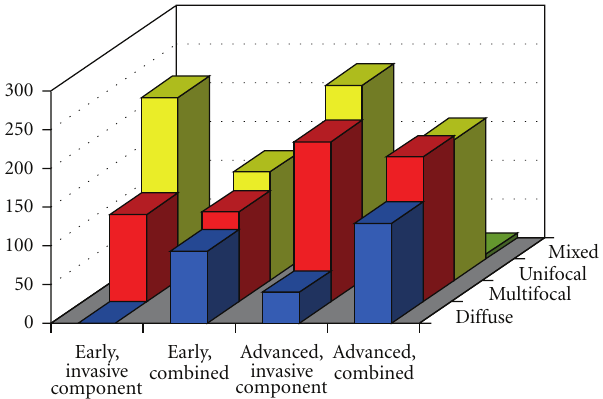
Figure 3: Distribution of the invasive component and combined (in situ plus invasive) lesion distribution in 855 consecutive invasive breast carcinoma cases documented in large-format histology slides. Falun, Dec 2007 to Jun 2012.